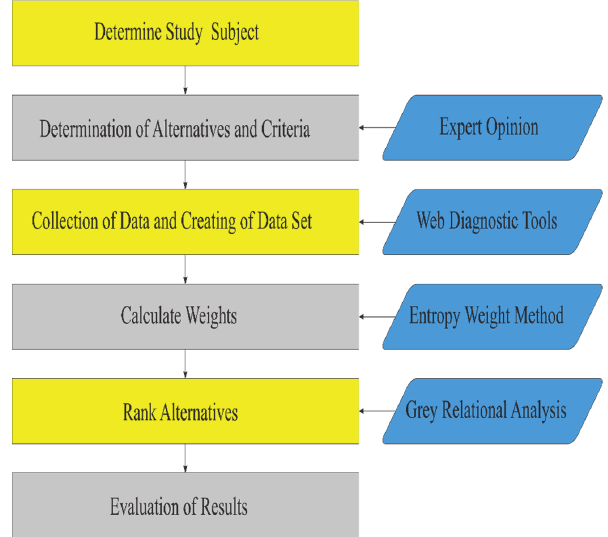
Fig. 1. Methodological